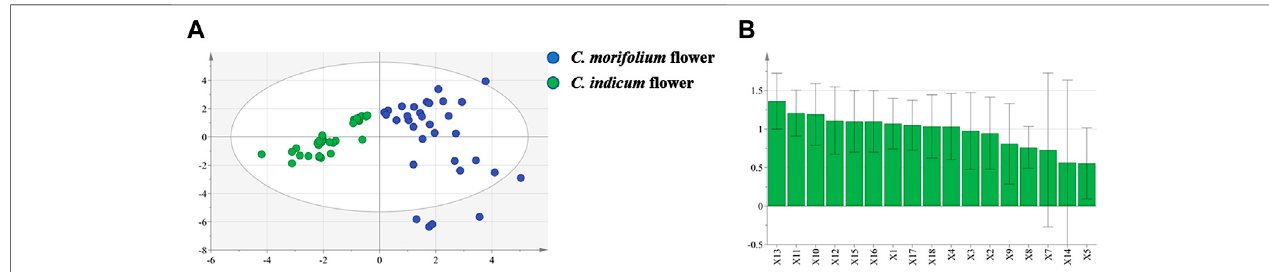
FIGURE5| OPLS-DAprojectionplotsinHPLC fi ngerprintanalysis: (A) Scoreplotof33samplesof C.indicum fl owers(CI)and 53samplesof C.morifolium fl owers (CM) from different origins; (B) VIP values of the components in differentiating CM and CI.